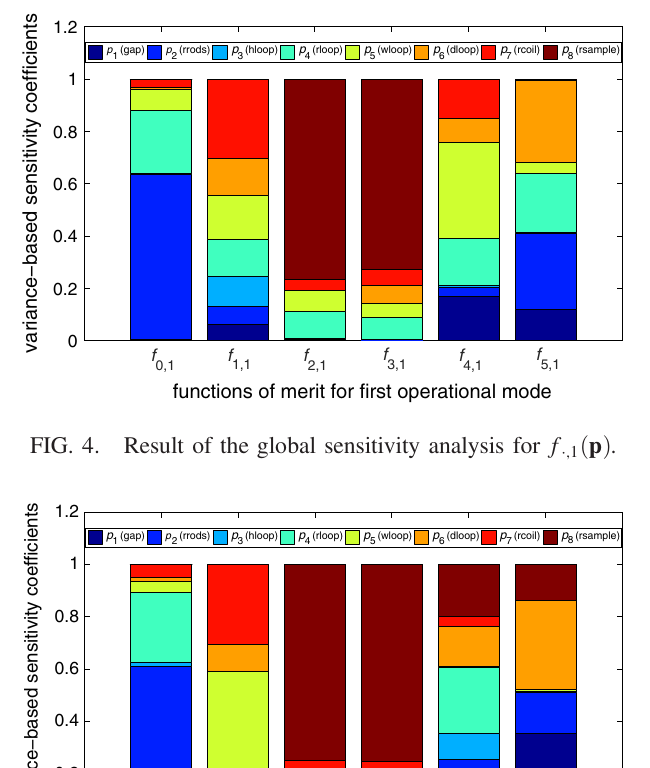
and standard deviation σ q